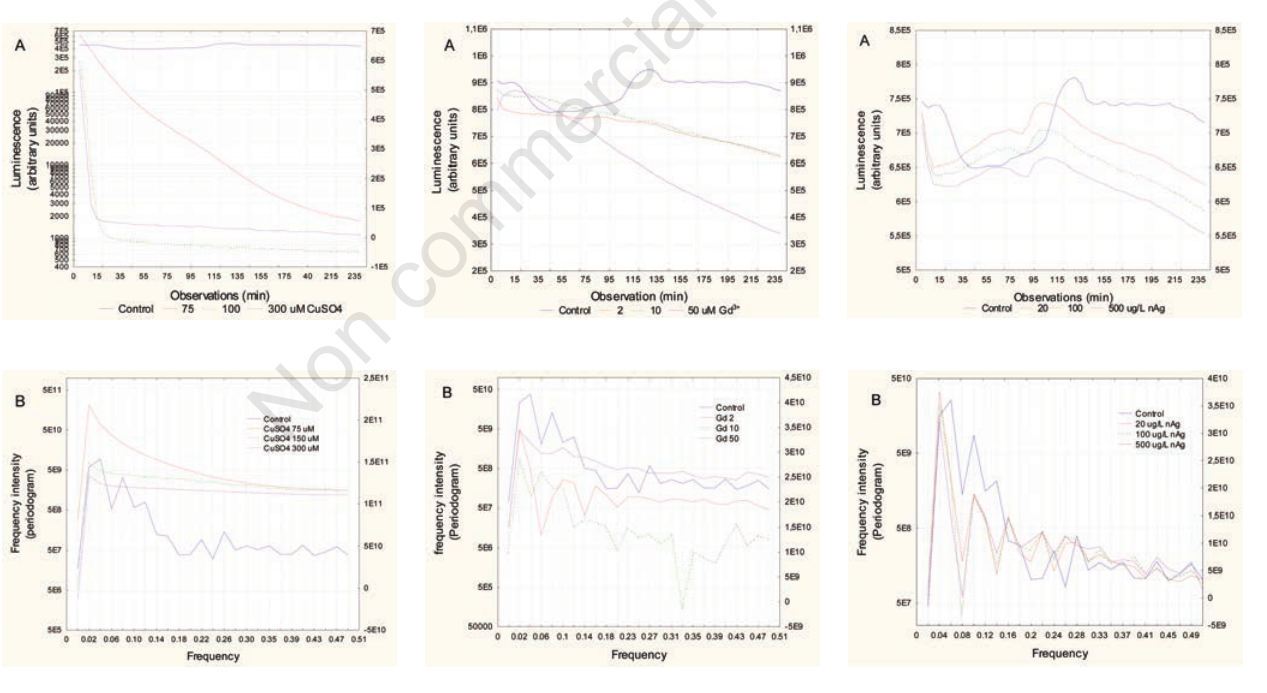
Figure 3. Changes in luminescence over Figure 2. Change in luminescence in bacte- time in bacteria exposed to Gd. Bacteria rial suspension exposed to CuSO4. were re-suspended at 20 million cells/mL Bacteria were re-suspended at 20 million in 2% NaCl containing increasing concen- cells/mL in 2% NaCl containing increasing trations of GdCl3. Luminescence was concentrations of CuSO . Luminescence 4 recorded at 5-min intervals for 3 h at 20°C was recorded at 5-min intervals for 3 h at under constant agitation. Recorded lumi- 20°C under constant agitation. Recorded nescence at each time (A) and frequency luminescence at each time (A) and frequen- analysis by Fourier transformation (B) are cy analysis by Fourier transformation (B) shown. are shown.